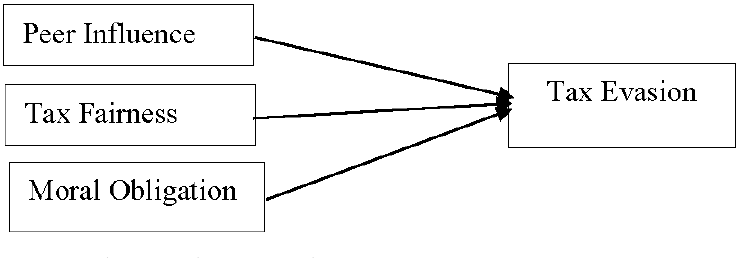
Figure 1. Theoretical Framework.